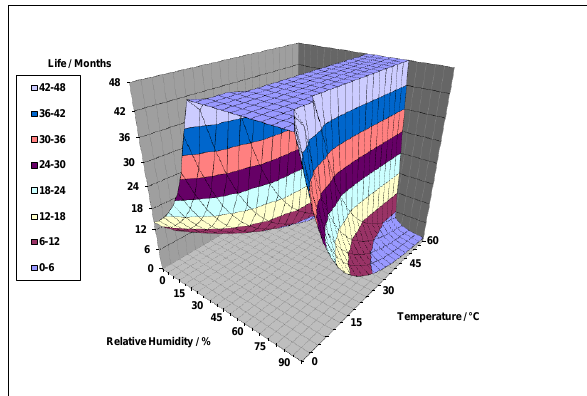
Figure 8. Example of electrochemical oxygen pump model outputs. Lifetime predictions for continuous operation at selected temperatures and relative